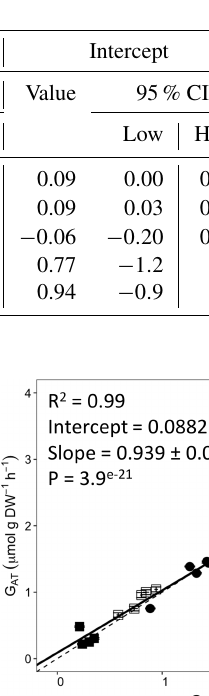
Table 4. Model II regression results of the comparison between calcification rates estimated using the different methods considered in this study: the alkalinity and calcium anomaly techniques ( G A and G Ca , respectively) as well as the 45 Ca and 13 C incorporation techniques T ( G 45 and G 13 , respectively). The number of samples ( n ), the regression coefficient ( R 2 ), the slope and intercept (including their 95% Ca C confidence intervals, 95% CI), and the p value are shown for each comparison. Few identified outliers ( n = 4) have been removed from the analyses; see Tables 3 and S1 in the Supplement.